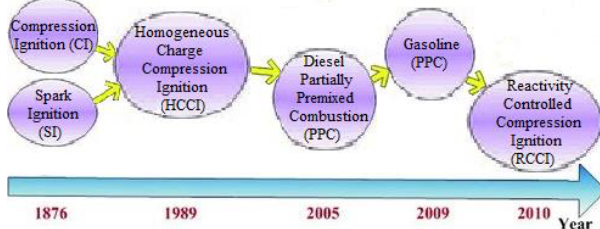
Fig. 2. Chosen ignition methods in ICE by year of construction (own graphic based on data and graphics from [25])